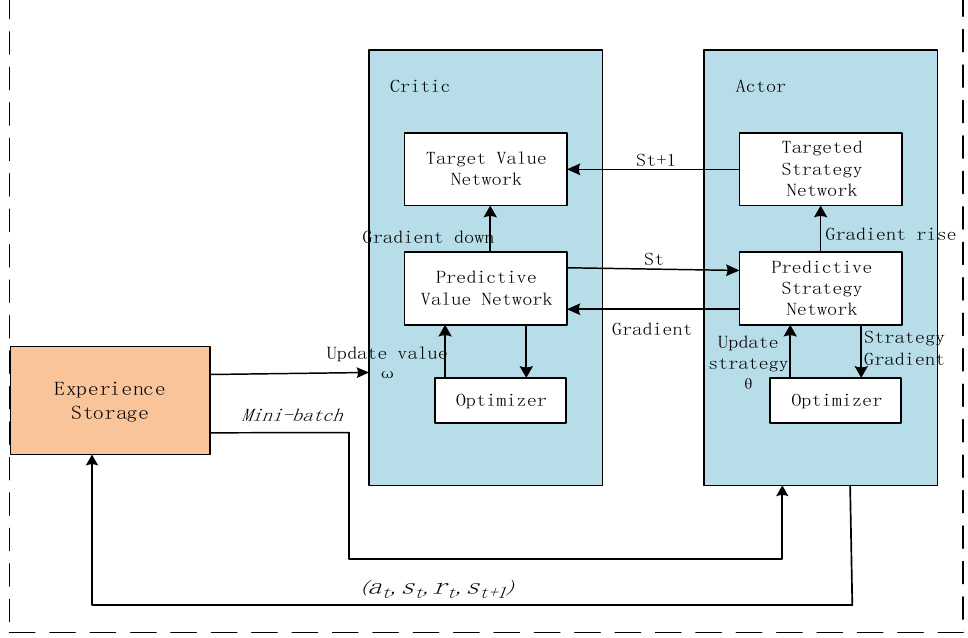
Figure 4. PES-ACNN neural network model training Figure 4. This is a figure. Schemes follow the same formatting.